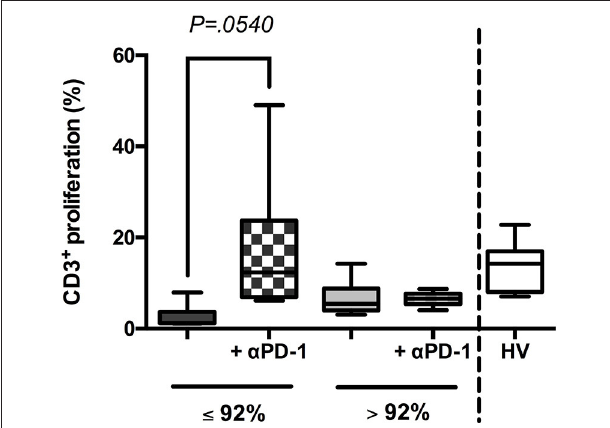
FIGURE 7 | Blocking PD-L1/PD-1 crosstalk restored immune response in patients with low oxygen saturation. Peripheral blood mononuclear cells (PBMCs) were isolated from 25 randomly selected patients with sepsis (SaO 2 ≤ 92%, n = 13 and SaO 2 > 92%, n = 12) and HV ( n = 5), labeled with CFSE and stimulated or not with PWD (2.5 µ g/mL) for 5 days, in presence or not of an anti-PD-1 [ α PD-1, (13)]. Then, proliferation of CD3 + cells was analyzed by FACS. Percentages of proliferation are shown in patients classified according to their oxygen saturation and HV. P -value using two-tailed Student’s t